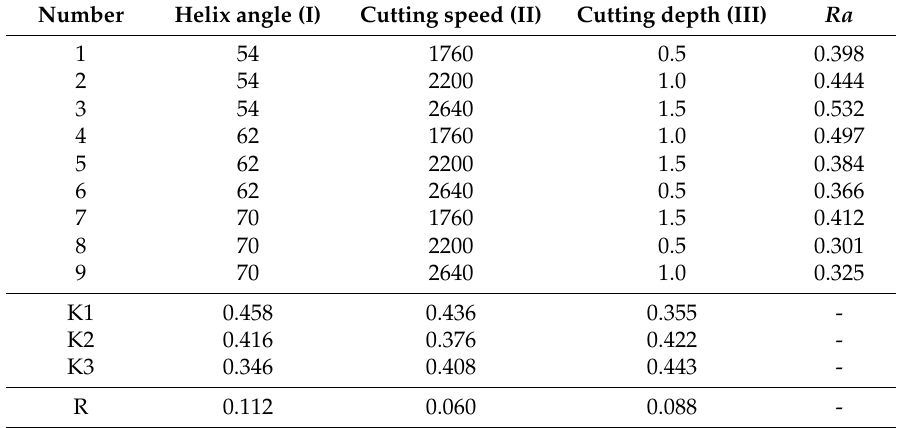
Figure 6. SEM micrograph of ripple ( a ), burr ( b ) and pit ( c ) generated under the cutting conditions of 3, 6 and 7, respectively. Table 6. Range analysis result of surface roughness ( μ m) under different helix angles (°), cutting speed (m/min) and depth (mm).